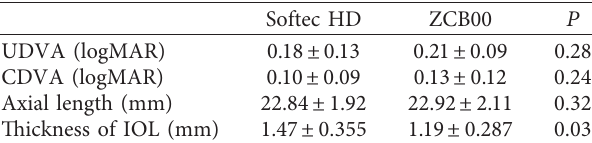
Figure 2: The scatter plot. Table 2: Postoperative results in the two study groups.